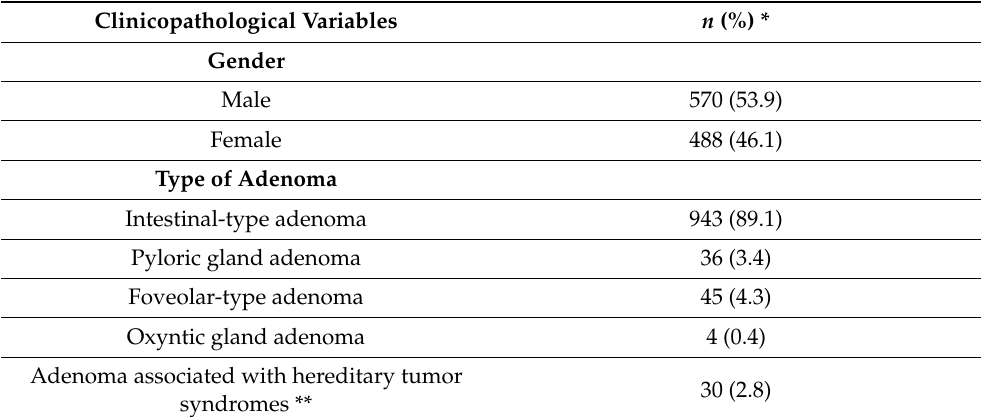
Table 1. Clinicopathological variables. * percentage with respect to available cases, rounded to the first decimal place; ** familial adenomatous polyposis (FAP)-associated adenomas (intestinal-type Adenoma, foveolar-type adenoma) and Gardner-Syndrome associated intestinal-type adenomas; *** synchronous adenomas; yr: years; NA: not available; OLGA: operative link on gastritis assessment; OLGIM: operative link on gastric intestinal metaplasia assessment. NA: in these cases, there was no gastritis status/OLGIM/OLGA